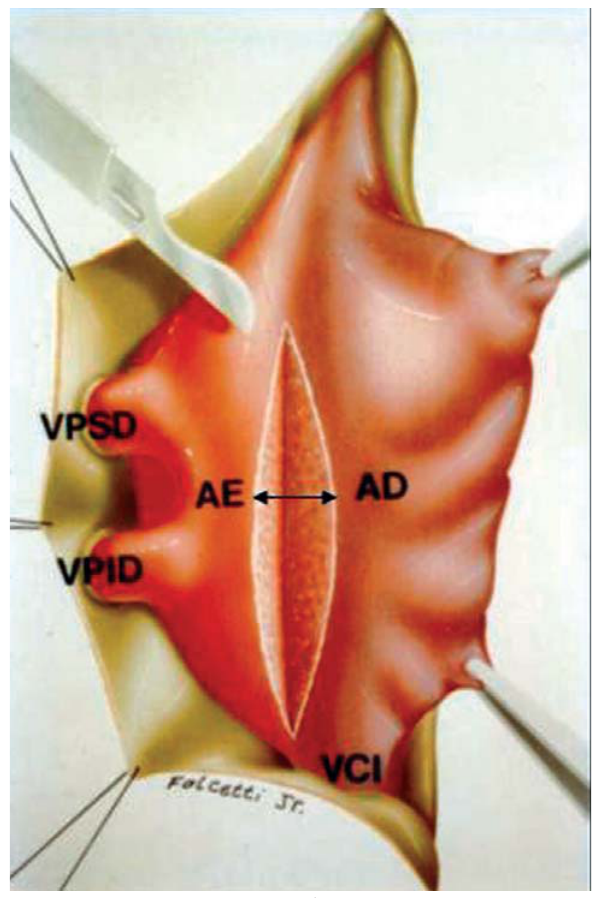
Fig. 2 - Ganho de parede atrial após a abertura do sulco interatrial